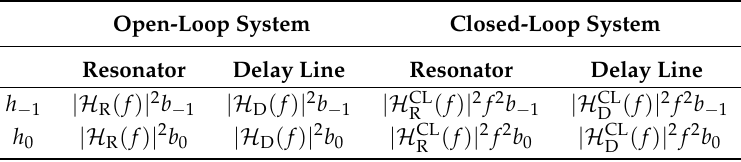
Table 3. Coefficients describing white phase noise ( h 0 ) and flicker phase noise ( h − 1 ) at the output of an open-loop and a closed-loop system. The white phase noise and flicker phase noise of the sensor are described by b 0 and b − 1 ,